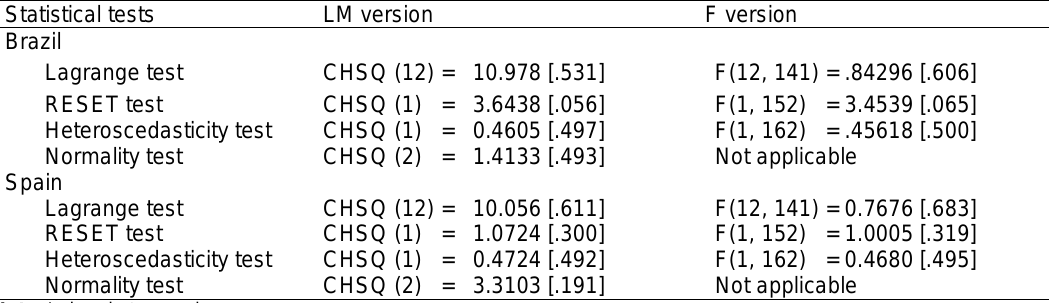
Table 4. Results of the different tests of the ARDL